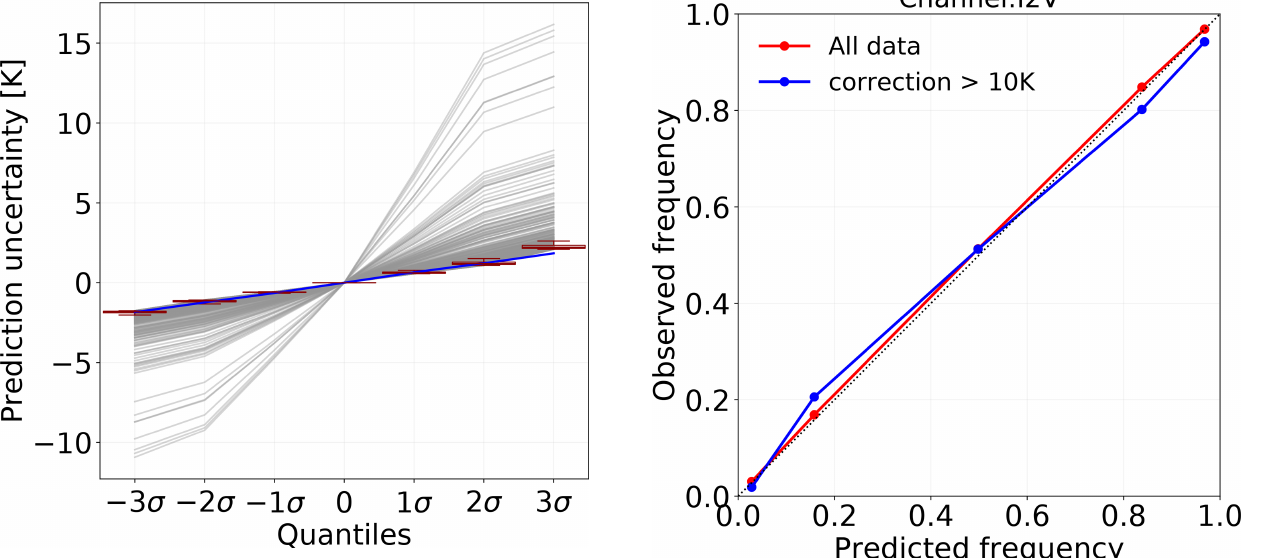
Figure 10. Same as Fig. 6 but from QRNN-single for ICI channel I2V. The blue line represents a Gaussian distribution with a standard deviation of 0 . 65K.